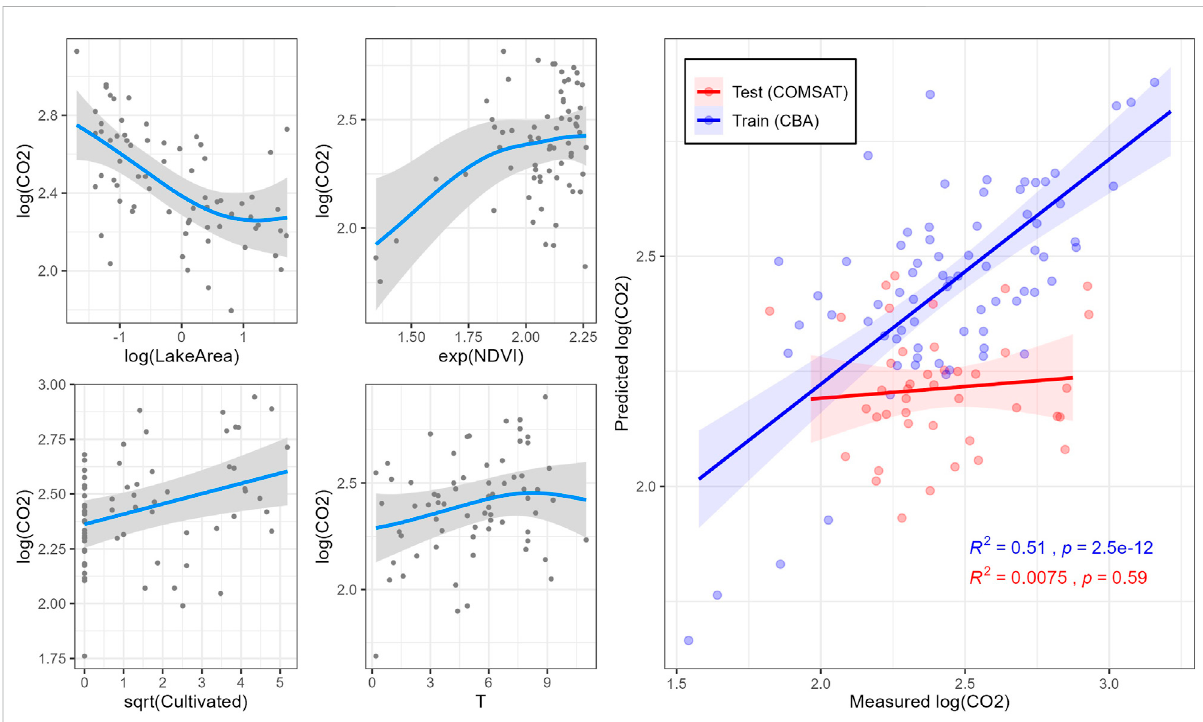
FIGURE 5 Simulations (blue lines) of normalized relative CO 2 saturations in the CBA dataset by generalized additive model (GAM) 2. On the right side, model training with CBA dataset (red) and test with COMSAT dataset (blue) for each model. Shaded gray areas indicate 95% con fi dence